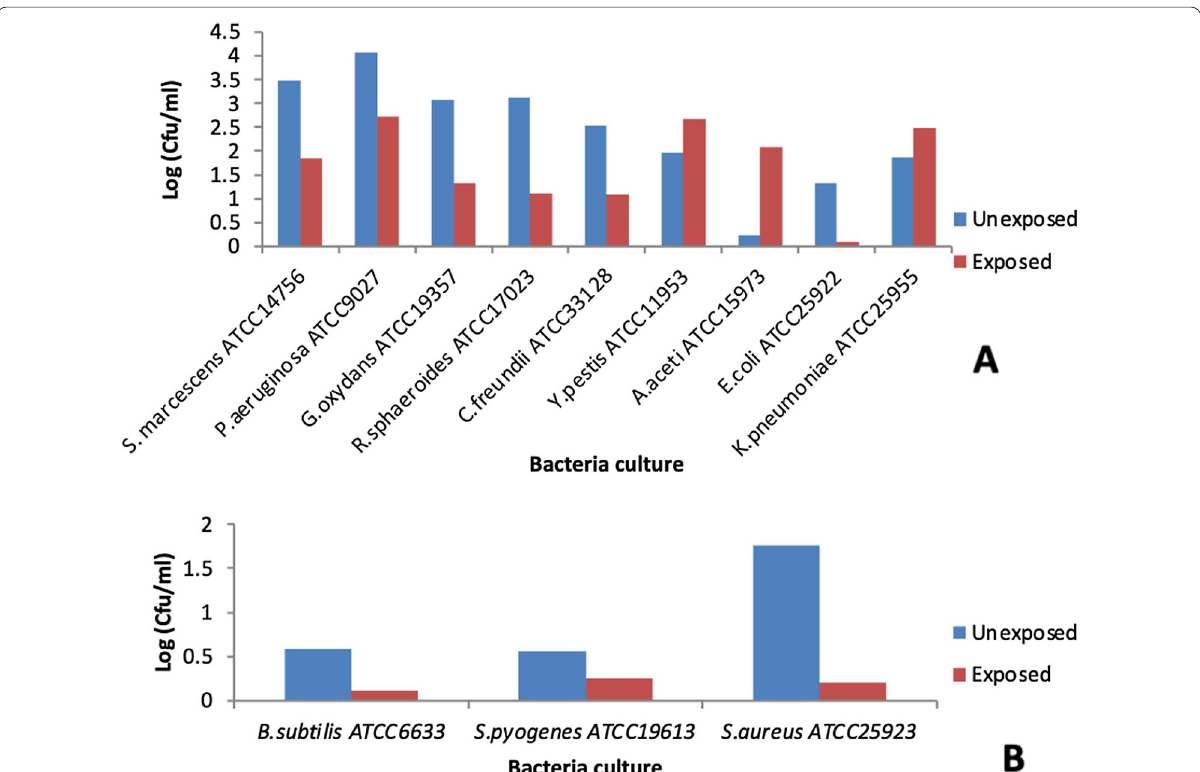
Fig. 3 Growth of selected Gram‑negative bacteria ( a ) and Gram‑positive bacteria ( b ) after treatment to electromagnetic flux of 5 mT intensity after 24 h of incubation compared with unexposed